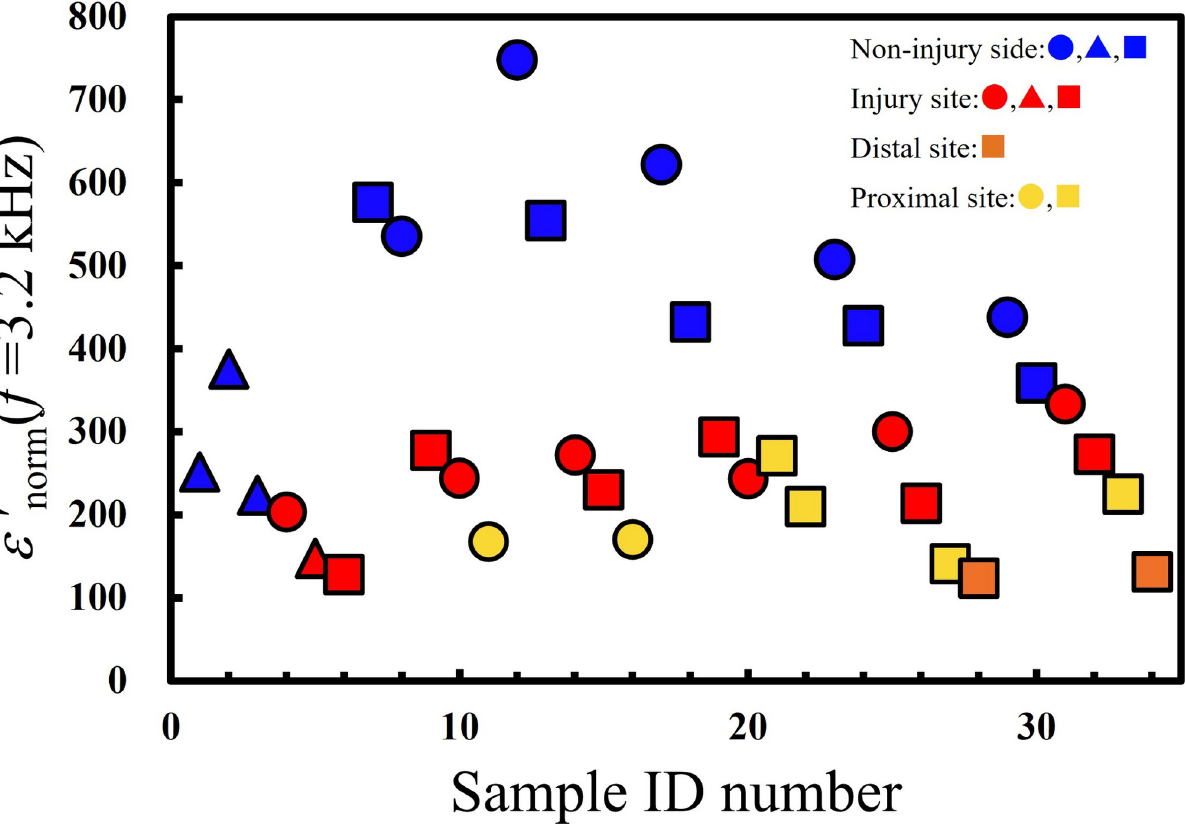
Fig 7. Plots of ε 0 at 3.2 kHz normalized by ε 0 ( f = 1.6 MHz) of the nerves. The shapes indicate the applied voltage as 0.1 V (circles), 0.5 V (squares), and 1.0 V